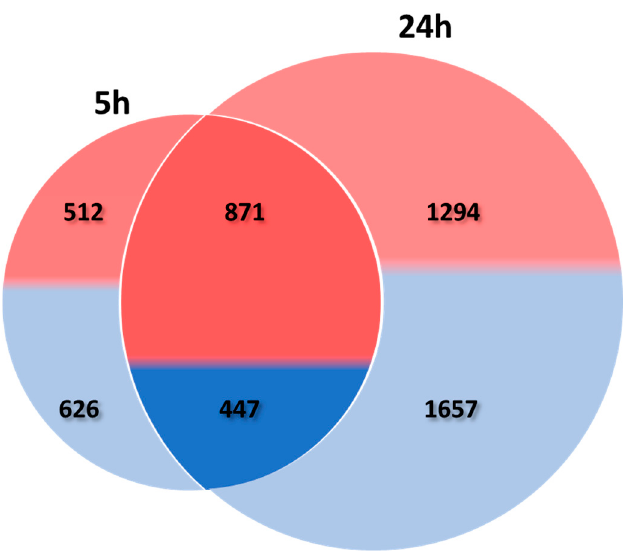
Figure 3. Venn diagram representing the DEGs in tomato leaf after 5 h and 24 h herbivory. The proportion of up- and down-regulated DEGs is shown by the proportion of pink/red and blue respectively. The number of up- and down-regulated DEGs is also indicated. The left circle represents DEGs after 5 h, the right circle, DEGs after 24 h, and the intersection between the two circles the DEGs common to 5 h and 24 h of herbivory.